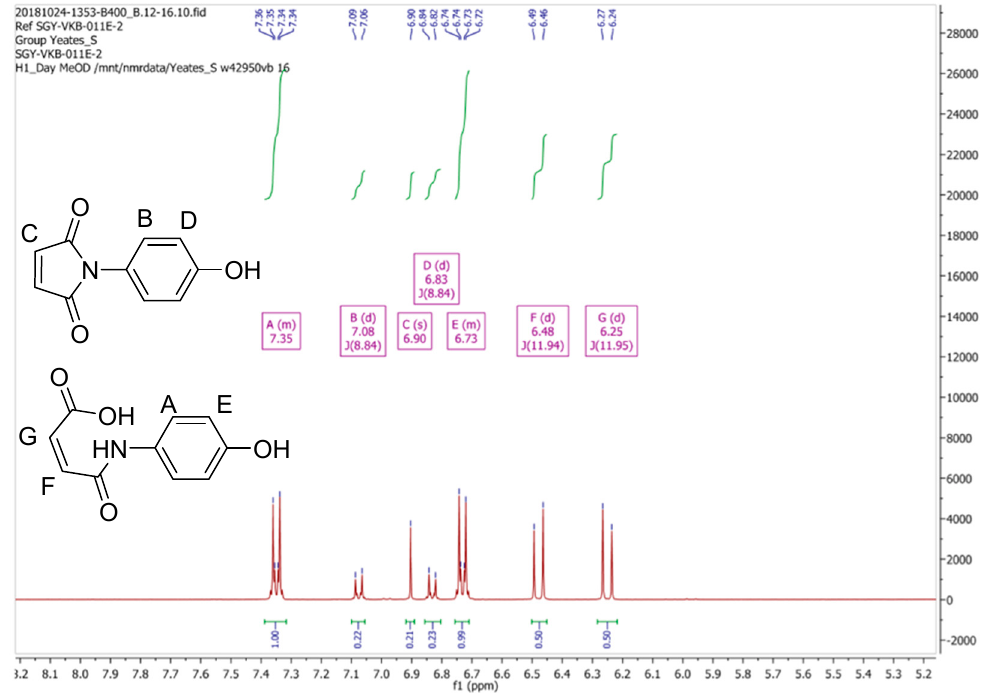
Figure 4. 1 H-NMR spectrum of N -(4-hydroxyphenyl)maleimide 2 in CD 3 OD after equilibration for 1 h.